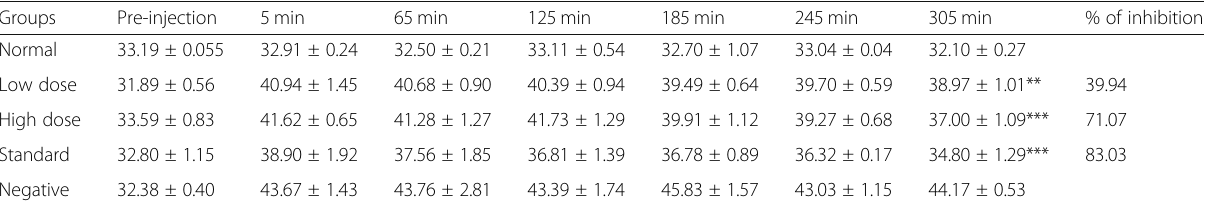
Table 1 Change in paw circumference (in mm) in different time intervals (in min) after the injection of carrageenan in the left hind paw of Wistar albino rats Groups